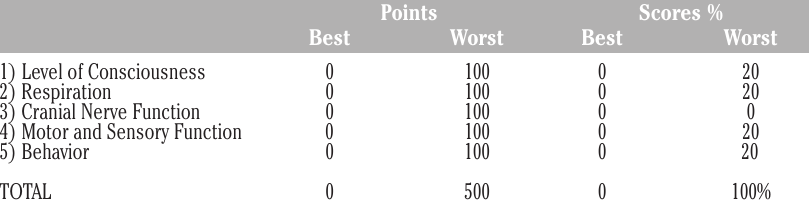
Dog #1 - Room Temp.